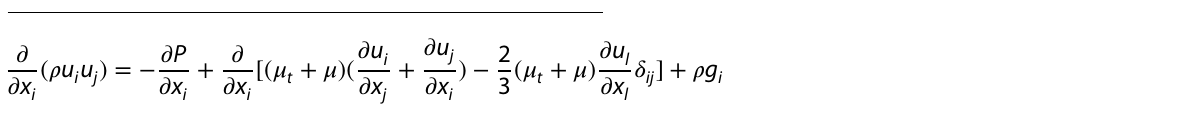
Fig. 1 Schematic flow chart of the Stefan–Boltzmann constant, reflectivity and incident energy flux for kth surface. F defined as surface to surface view factor and A is are of the surfaces. (ii) Internal flow and heat transfer inside the WCP are provided in Eqs. 6−12 [9, 24].